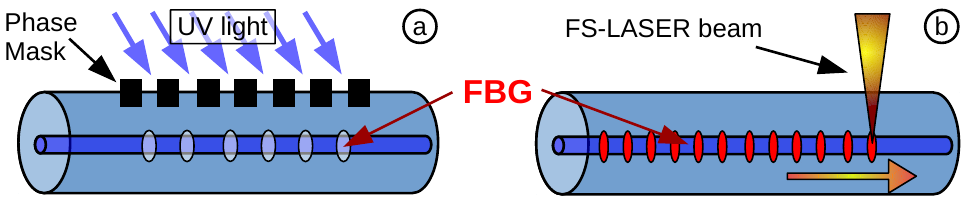
Figure 4. ( a ) FBG inscription into a photosensitive single-mode fibre (SMF) by using a phase mask and UV light; ( b ) FBG inscription by a femtosecond laser (FSL), which can be tailored to every optical